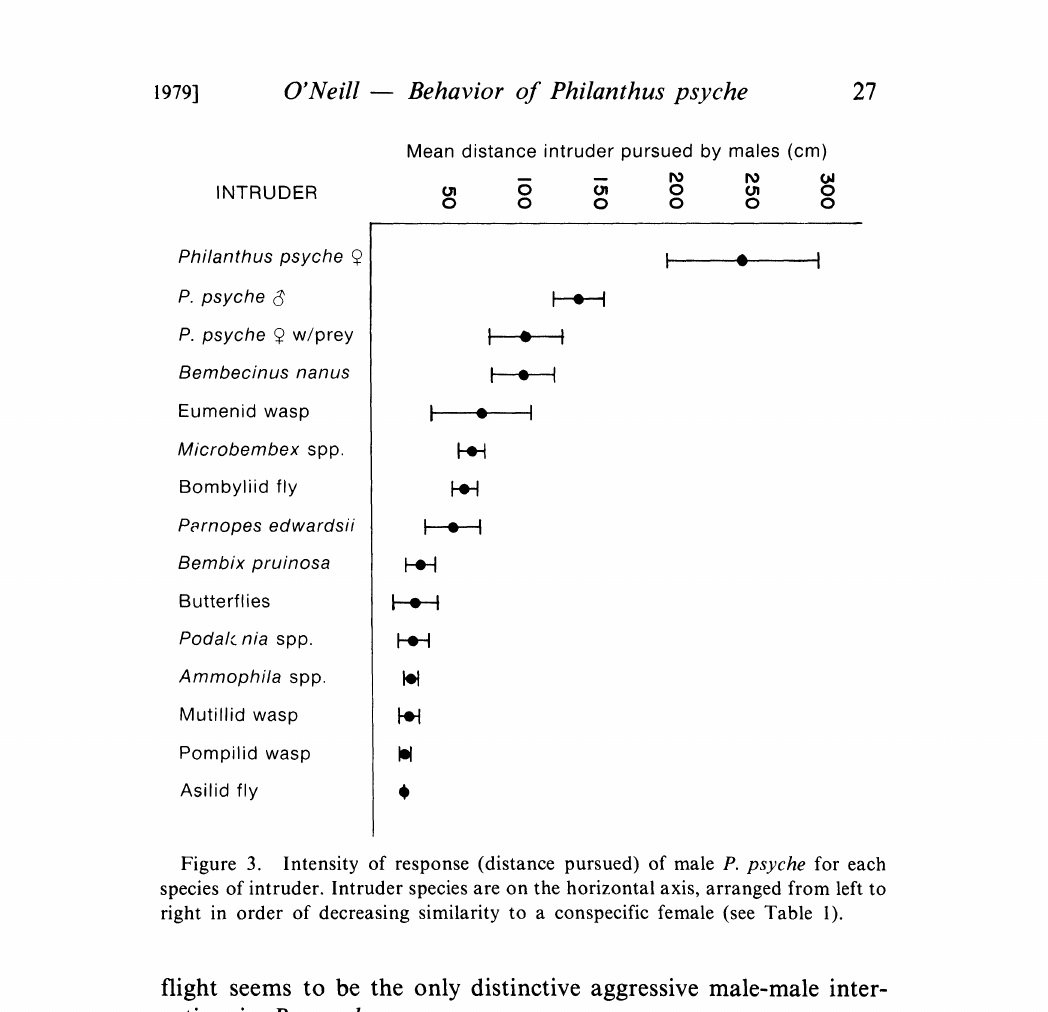
Figure 3. Intensity of response (distance pursued) of male P. psyche for each species of intruder. Intruder species are on the horizontal axis, arranged from left to right in order of decreasing similarity to a conspecific female (see Table